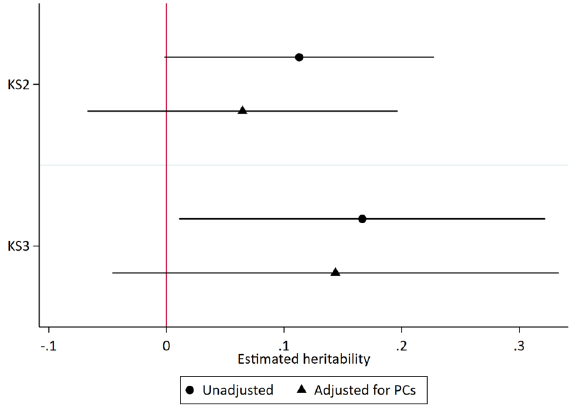
Figure 1. Estimated SNP heritability of teacher expectation accuracy at Key Stage 2 (age 11) and Key Stage 3 (age 14). Models control for the first 20 principal components of population